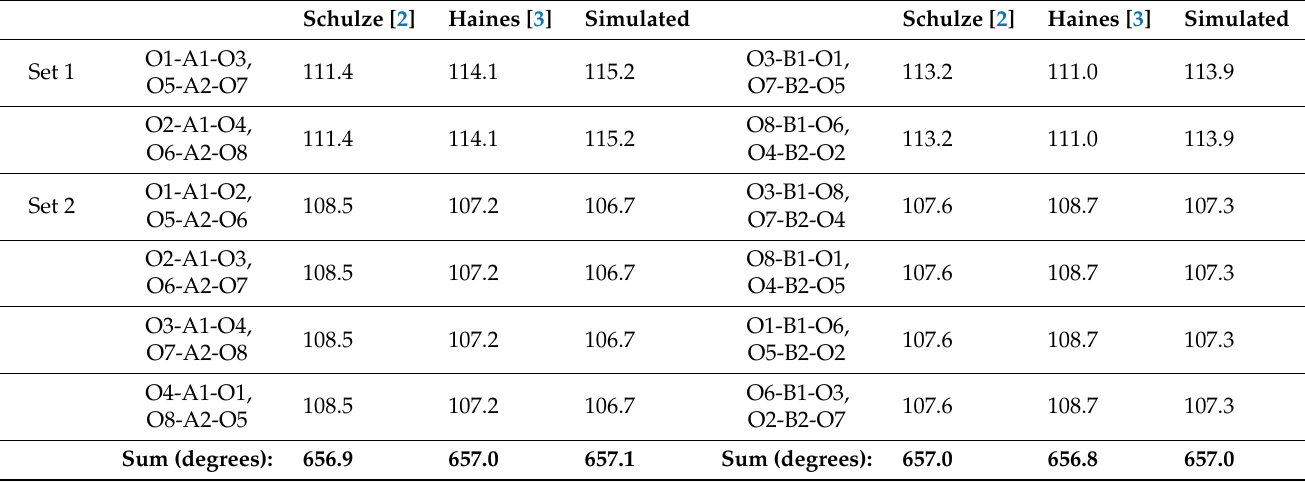
Table 1. The O-X-O (X = As, B) angles, in degrees, as measured from experimentally / DFT obtained structures. The protocol used for the simulations is outlined in Appendix A and the O-X-O angles are defined in Figure 2. Note that for each tetrahedron, the sum of the six O-X-O angles is approximately 657 ◦ in accordance with McNelis and Blandino [60].